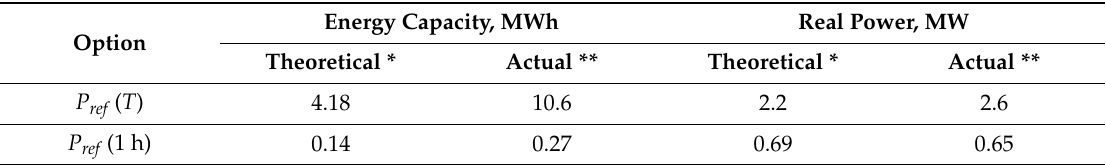
Table 1. Rated battery energy storage system (BESS) power and capacity. Option